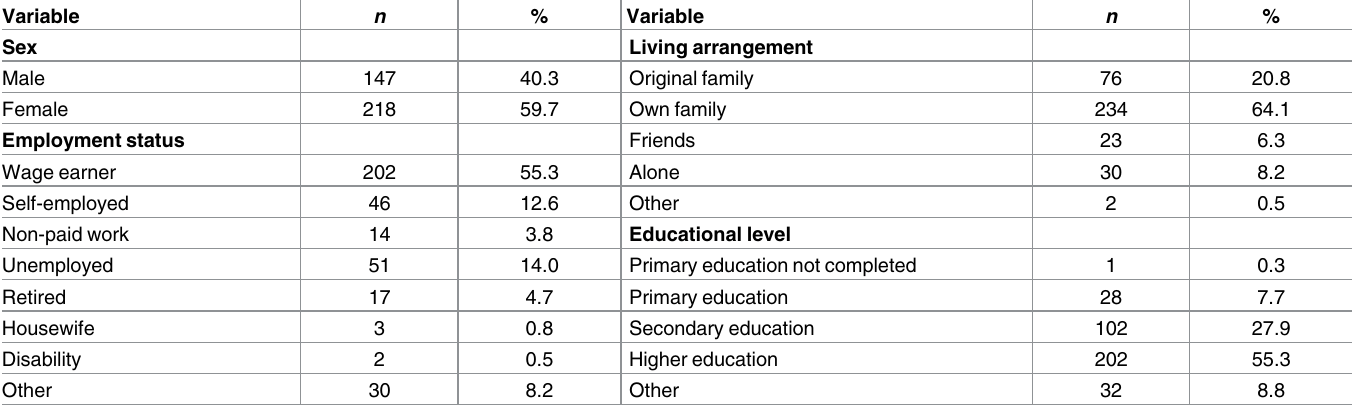
Table 1. Socio-demographic characteristics of the